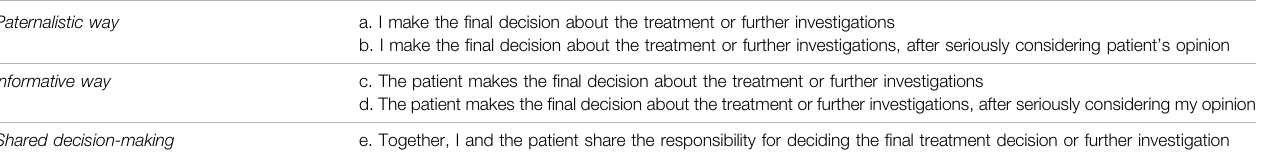
TABLE 1 | Physicians ’ actual decision-making role based on the Control Preference Scale